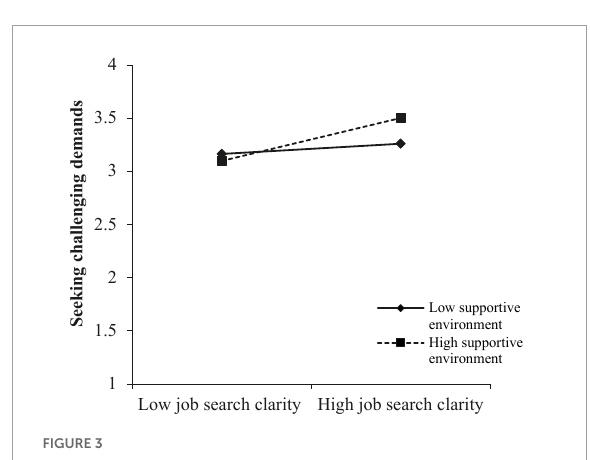
FIGURE3 Moderation effect of supportive environment on the relationship between JSC and